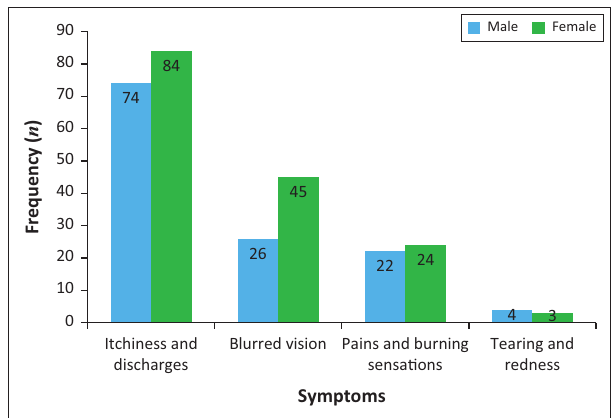
FIGURE 3: Distribution of ocular symptoms experienced by participants stratified for